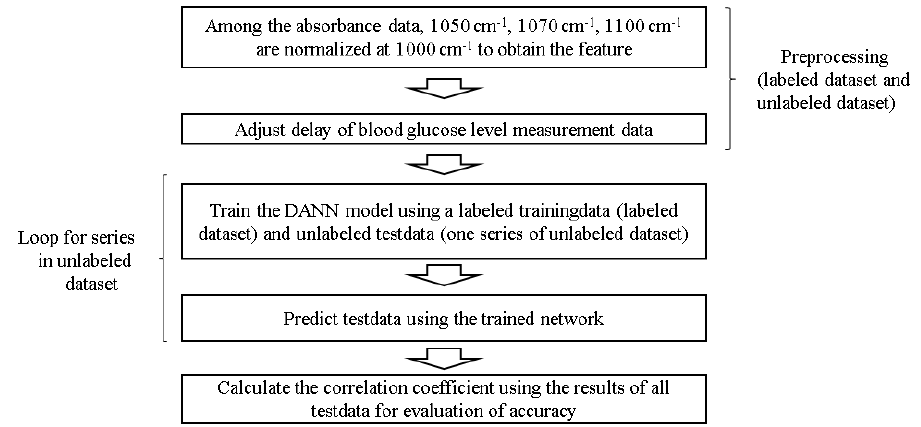
Fig. 2. Process °ow of training and evaluation of prediction